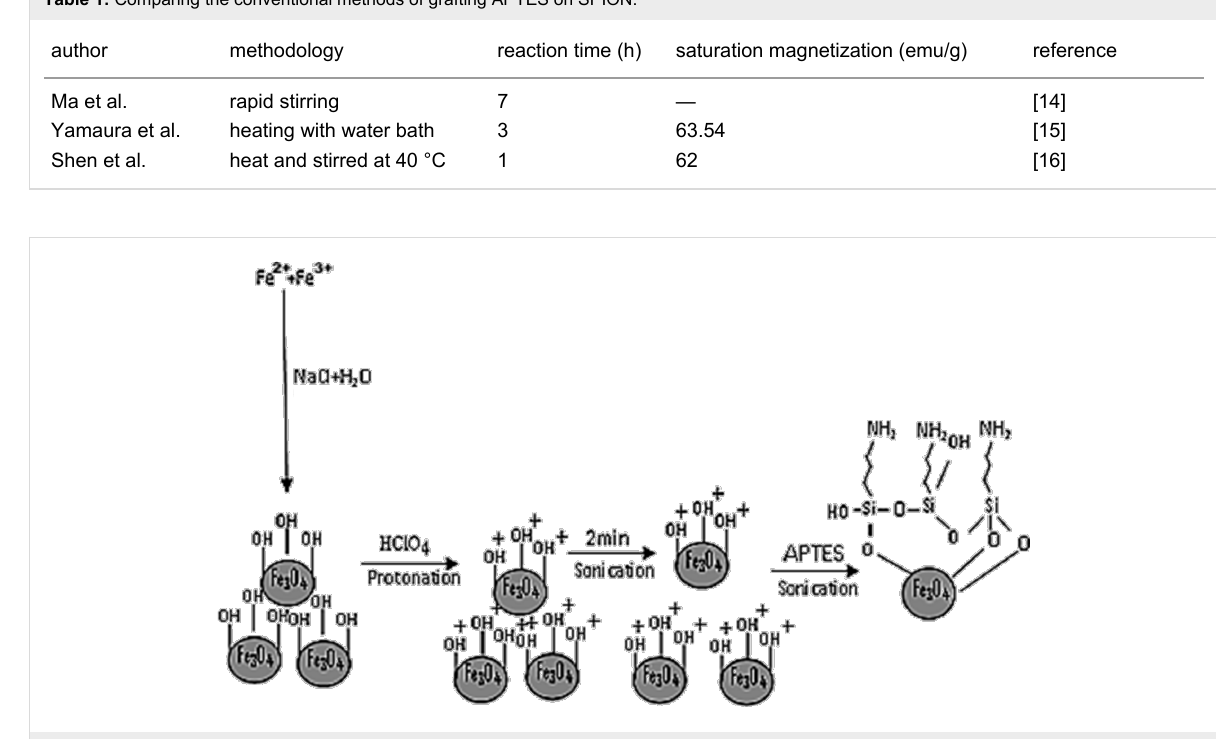
Scheme 1: Schematic representation of the sonochemical synthesis of APTES-functionalized